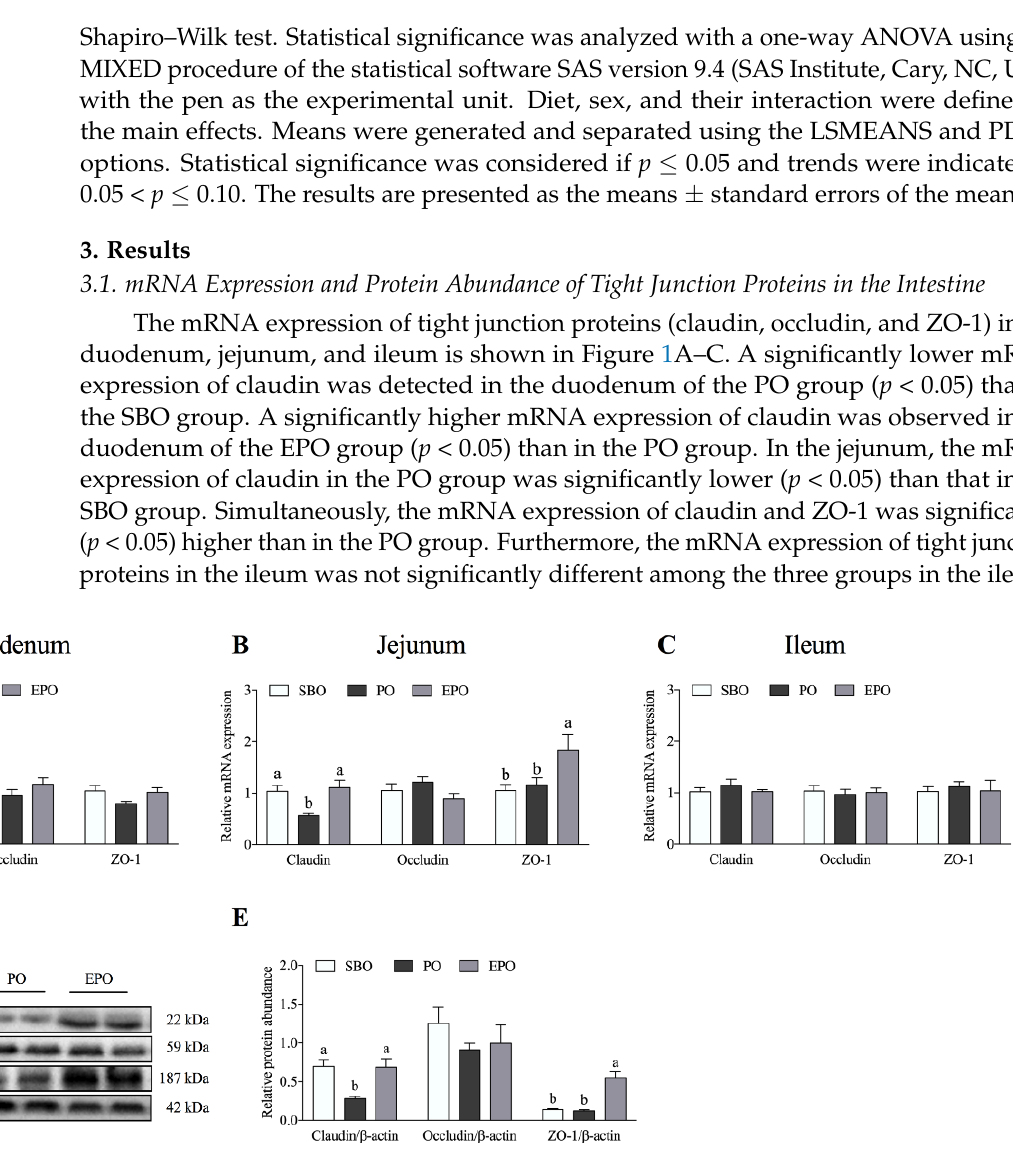
Figure 1. Expression and abundance of intestinal tight junction mRNAs and proteins. ( A – C ) The mRNA expression of tight junction proteins in the duodenum ( A ), jejunum ( B ), and ileum ( C ). ( D , E ) The abundance of tight junction proteins in the jejunum. SBO, soybean oil group; PO, palm oil group; EPO, encapsulated palm oil group. Different letters (a, b, and c) indicate a significant difference among different treatments ( p < 0.05).